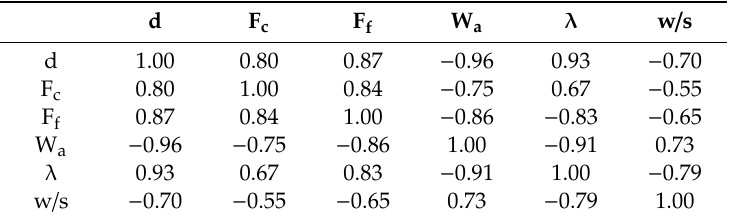
Figure 8. Correlation diagram between response variables (d, F c , F f , W a , λ , and w / s). Table 4. Pearson correlation coefficients for each pair of response variables (d, F c , F f , W a , λ , and w/s).